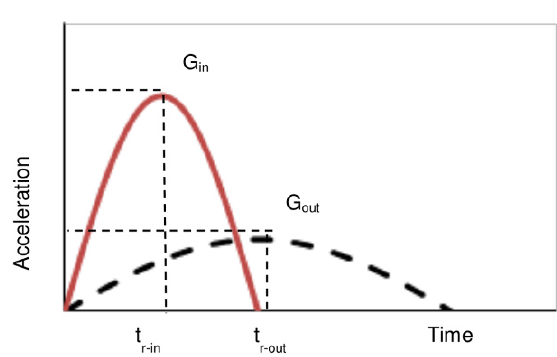
Figure 4. Typical input-output in shock mitigation